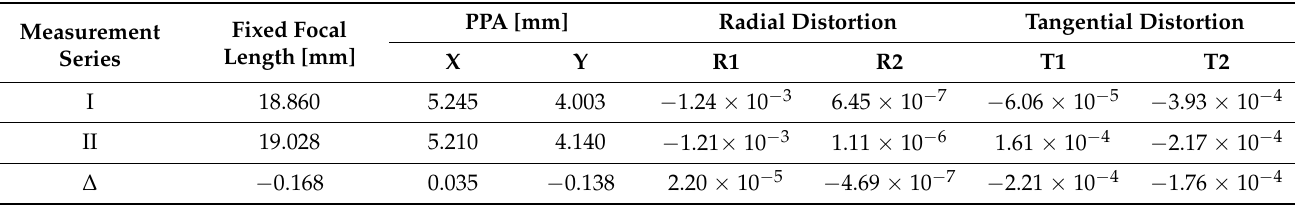
Table 5. Differences in the determined parameters of interior